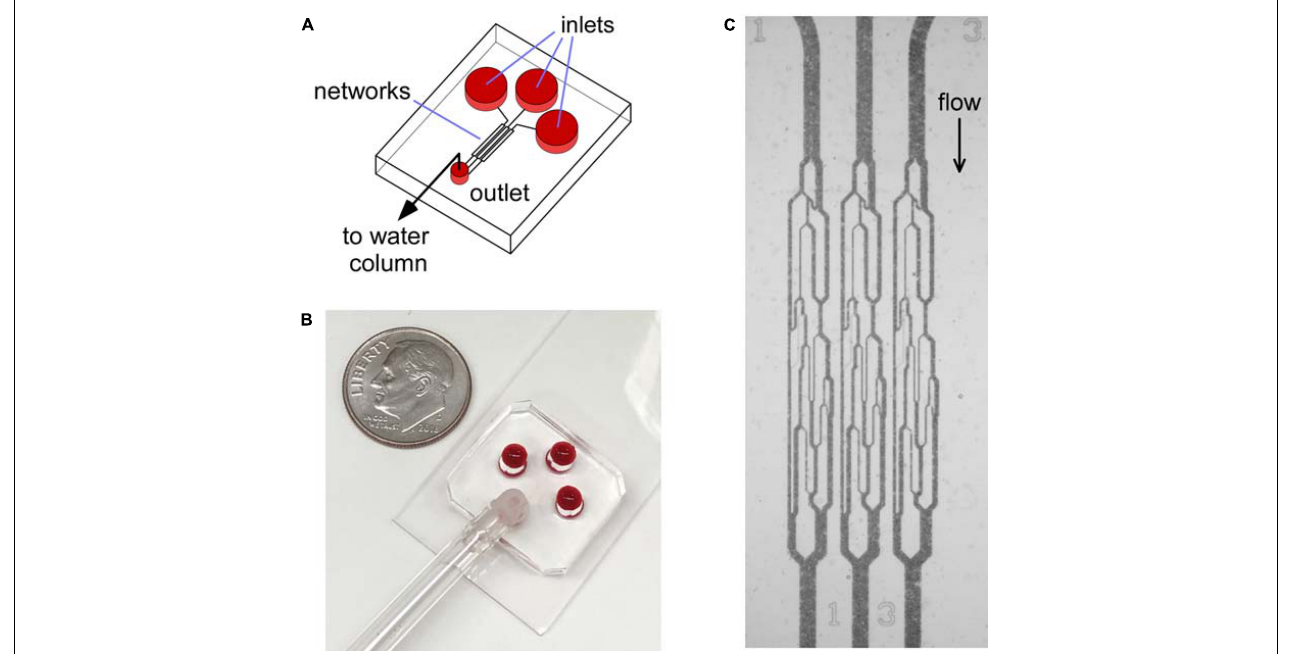
FIGURE 1 | Illustration of the AMVN device setup. (A) Each device consists of three identical capillary networks, connecting three separate inlets to a common outlet. (B) Photograph of the AMVN device. Ten cent U.S. coin is shown for size reference. (C) A bright-field microscopy image showing the flow of blood in the capillary networks of an AMVN device. The device is illuminated through a blue filter to increase contrast (RBCs appear dark in blue